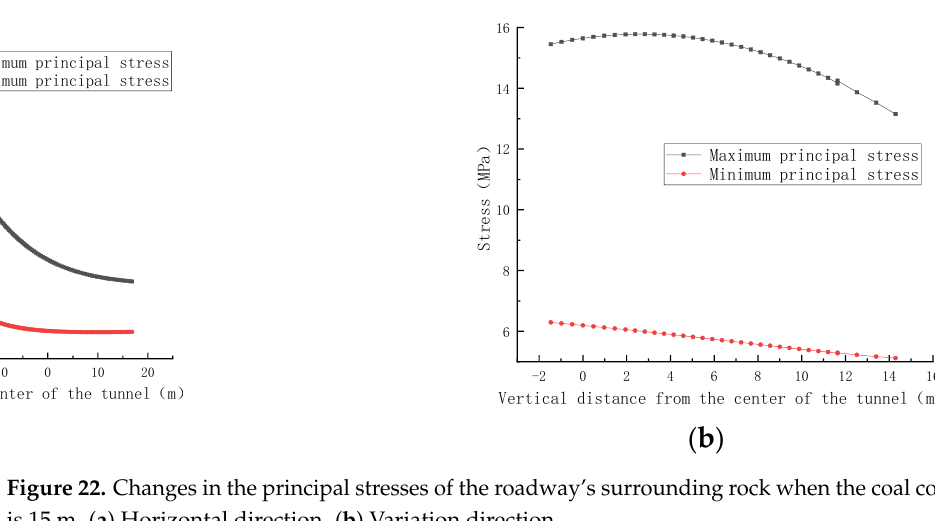
Figure 21. Principal stress distribution contour of the roadway’s surrounding rock when the coal column is 15 m. ( a ) σ 1 cloud. ( b ) σ 3 cloud.